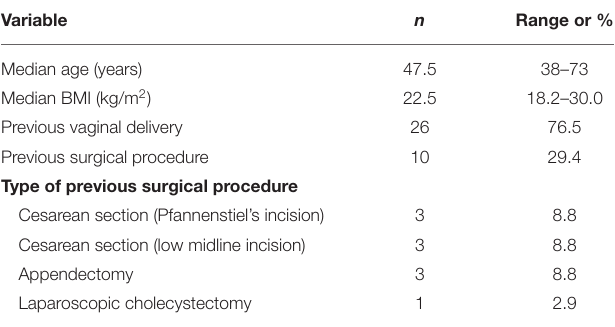
TABLE 3 | (A) Postoperative pain analysis. (B) Variables related to VAS measured immediately after